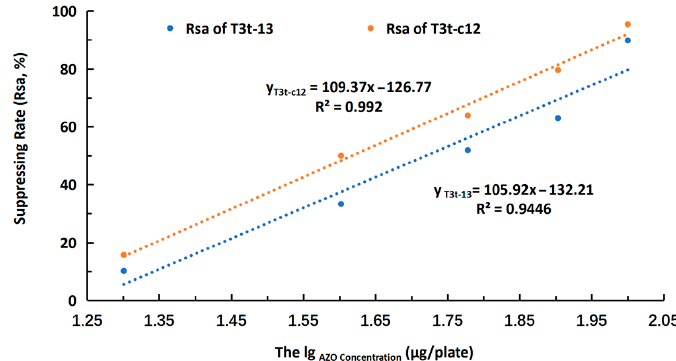
Figure 9. Correlation curve of AZO concentration and Rsa.